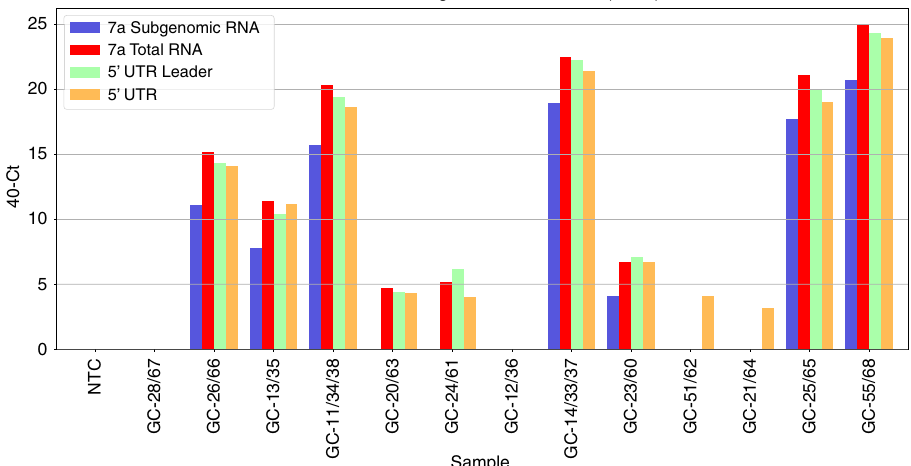
Fig. 4 Genomic and subgenomic PCR values shown as 40 minus Ct (40-Ct). The values are shown for each sample and for the four in-house PCRs detecting 7a subgenomic RNA only, 7a total RNA (i.e., genomic RNA and subgenomic RNA up to and including 7a), the 5 ′ -UTR (untranslated region) leader or the 5 ′ UTR. NTC non-template control